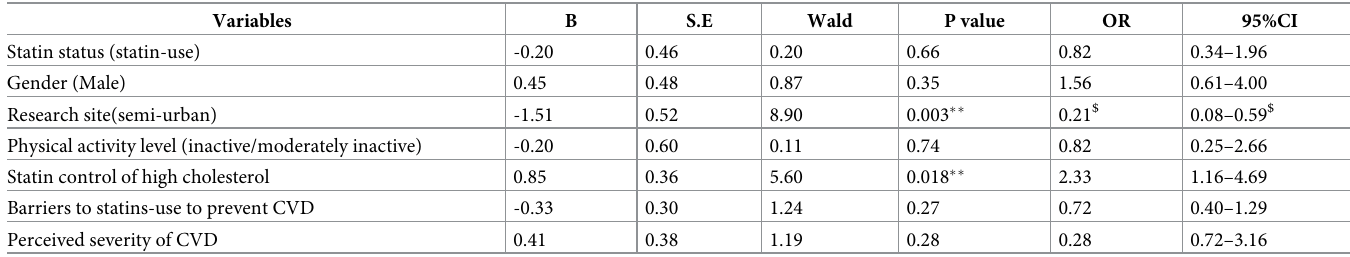
Table 6. Logistic regression model for the adoption of a low-fat